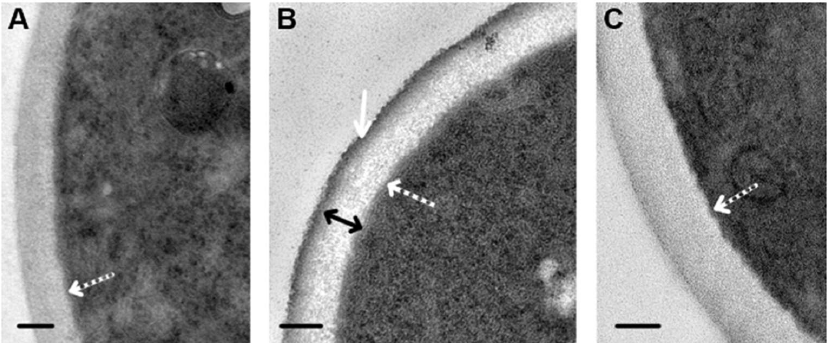
Figure 3. Ultrastructure of cell walls in intact C. albicans cells: ( A ) fixation in 2.5% GA, contrasting with UAc and LC. ( B ) fixation in a mixture of PFA and GA, contrasting with UAc and LC. ( C ) fixation in a mixture of PFA and GA, without contrasting. White dotted arrows show the plasma membrane; the white arrow shows the outer electron-dense layer; the two-way arrow shows the inner layer of the cell wall. Scale bars correspond to 200 nm. Ultrathin sections.